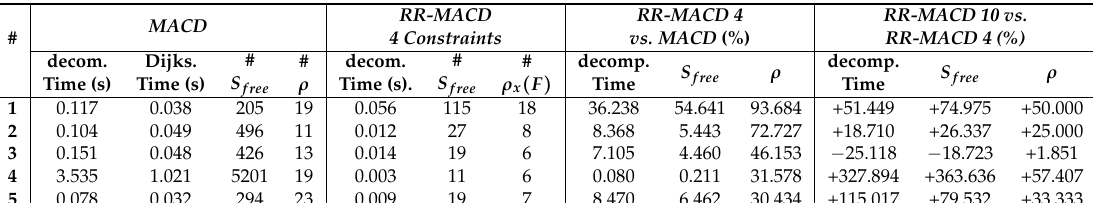
Table 5. Comparison of both algorithm executions for different environments. Column recursive rewarding modified adaptive cell decomposition ( RR-MACD ) 4 vs. MACD (%) shows the